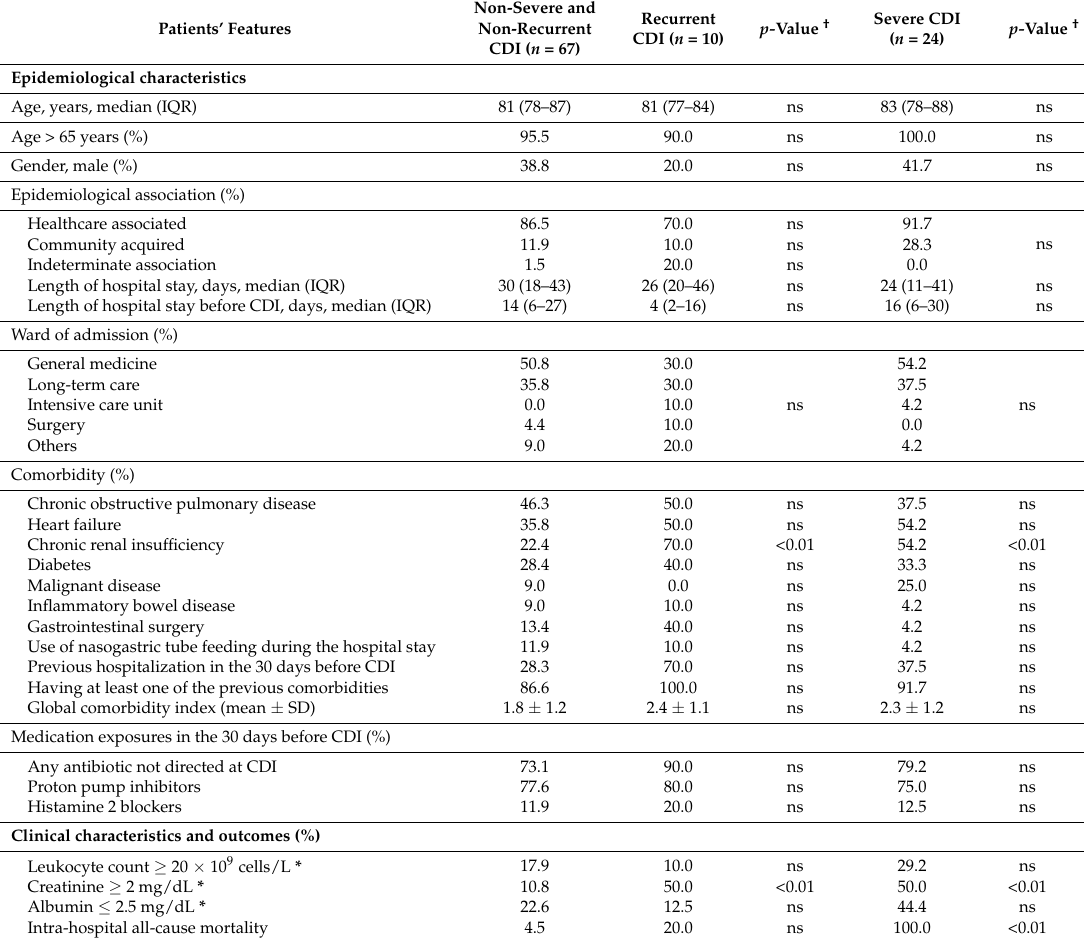
Table 5. Bivariate analysis of risk factors for recurrent and severe